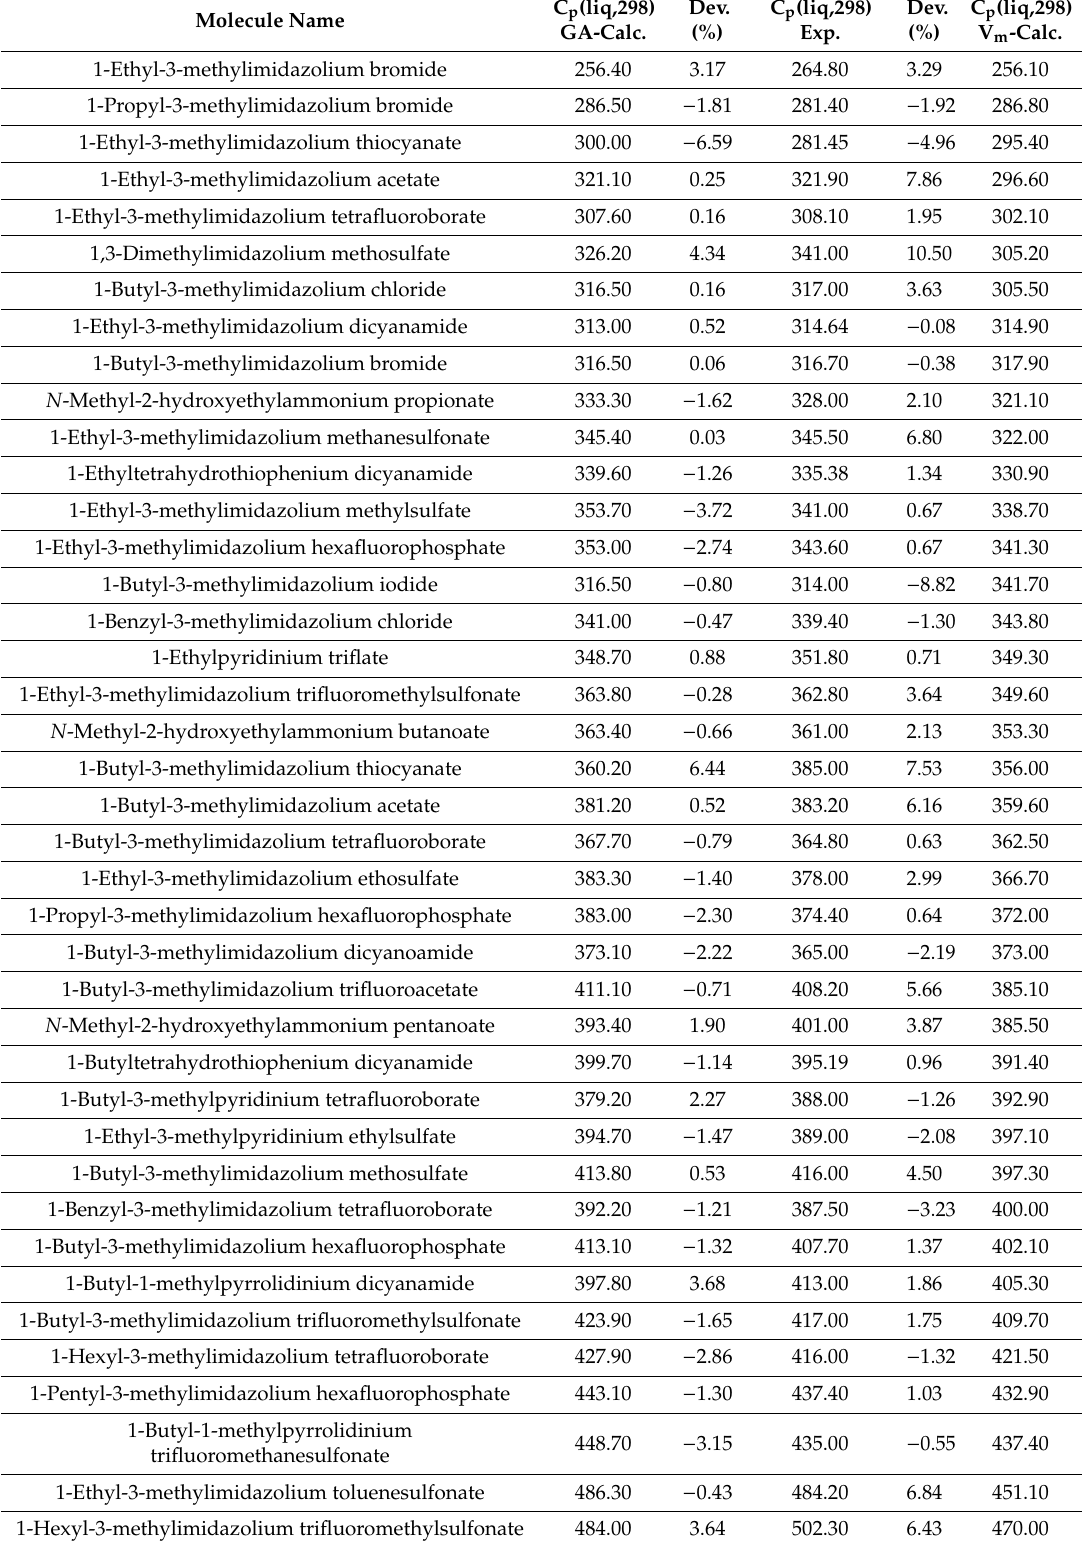
Table 6. Experimental C p (liq,298) data of 122 ionic liquids, compared with prediction values calculated by the present GA and the V m [1] method (in J / mol /